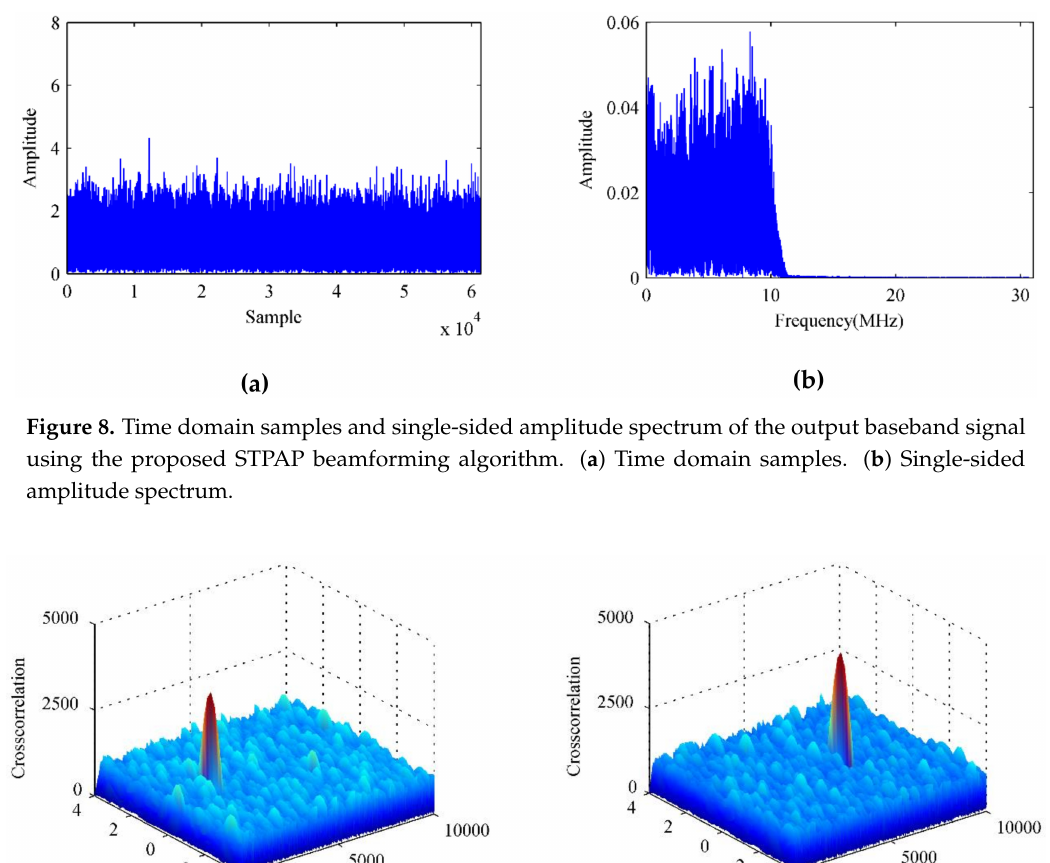
Figure 7. Iterative error signals changing with the iterative times.